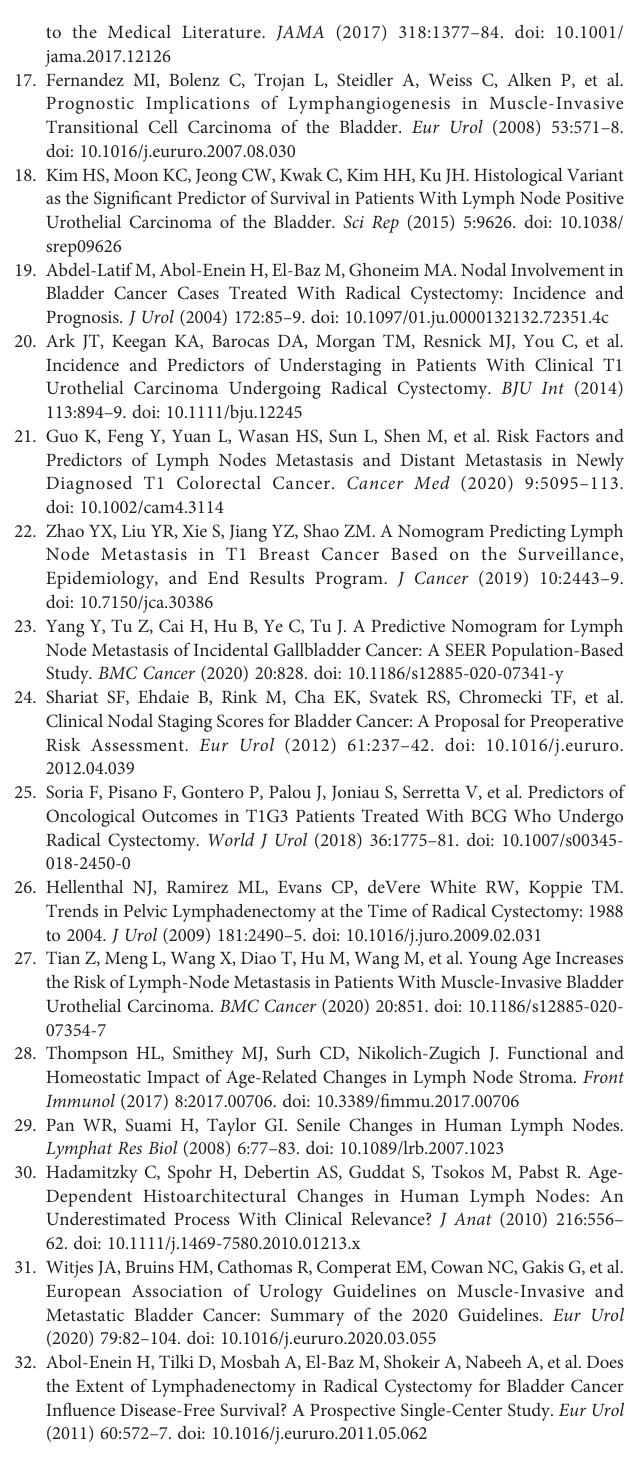
Supplementary Figure 3 | Calibration curve and decision curve analysis (DCA) for predicting overall survival in patients with bladder cancer. Calibration curve of the 3- (A) and 5-year (B) overall survival nomograms in the veri fi cation set (bootstrap method, 1000 repetitions). (C) The DCA curve of the veri fi cation set. The x-axis and y-axis mean the threshold probability and net bene fi t, respectively. The black line indicates that all patients areat low risk, whereas the greenline indicates that all patients are at high